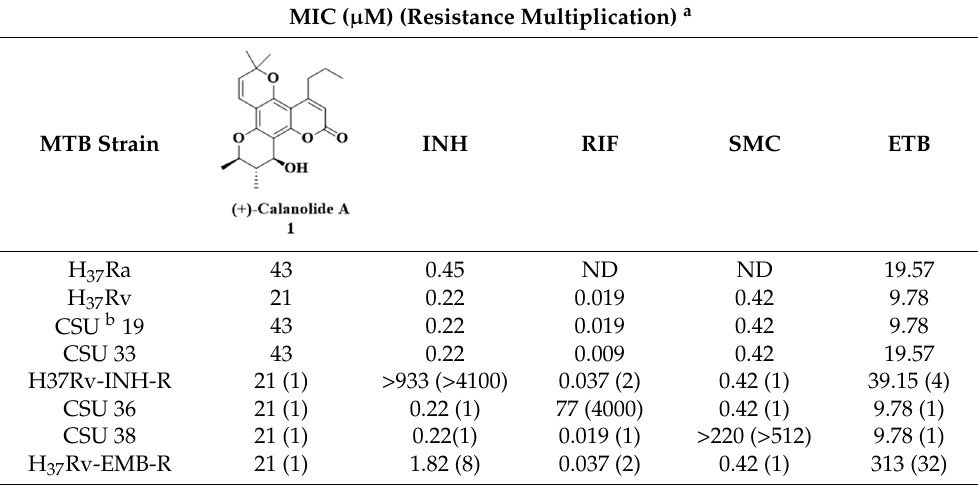
Data taken from Reference [60]. a The resistance multiplier is the ratio between the MIC value against the individual strains to the MIC value against the strain H 37 Rv. b CSU: Colorado State University (University of Colorado). ND: Not determined. Stavudine (d4T) is an NRTI used in anti-HIV therapy that has also been associated with anti-MTB drugs in the development of novel compounds to treat HIV-TB coinfections ( 2a – d ) (Figure 7) through the esterification of its 5 (cid:48) -hydroxyl group. This approach is commonly used to enhance brain uptake and in vivo efficacy of anti-HIV nucleoside derivatives [79]. The prodrugs of d4T had their half-lives (t 1/2 ) of hydrolysis determined in